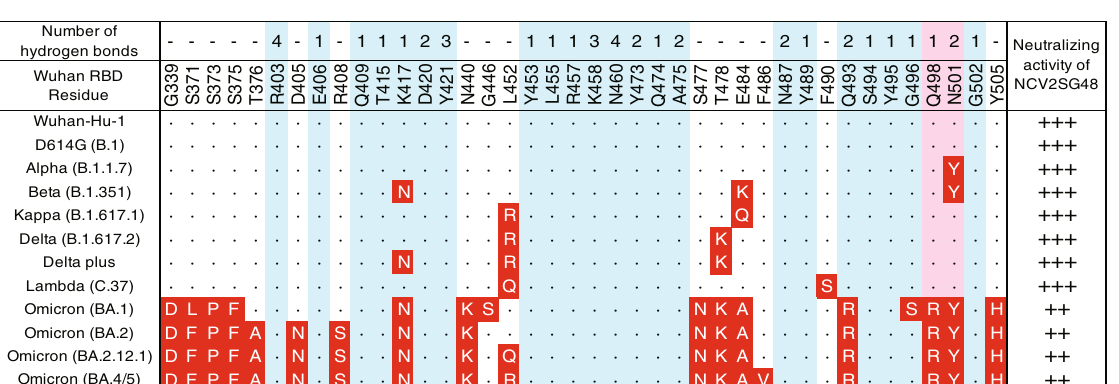
Fig. 5 Conserved binding of NCV2SG48 on Omicron RBD. a Fab of NCV2SG48 complexed with Wuhan RBD ( light red ) or Omicron RBD ( light blue ) is shown on the surface model of Wuhan-Hu-1 RBD. The binding angles of Fab to Wuhan RBD ( red line ) and Omicron RBD ( blue line ). The conformational con fl ict between NCV2SG48 and Omicron RBD is boxed and indicated by the arrow. Residues of a possible crush between NCV2SG48 and Omicron RBD are indicated by a purple dotted line. Wuhan-Hu-1 RBD ( orange ); Omicron RBD ( green ); S32 of NCV2SG48 LC, N501 and Q498 of Wuhan RBD, and Y501 and R498 of Omicron RBD are indicated. b The binding interface area of NCV2SG48 Fab, HC, and LC with Wuhan, Delta, and Omicron BA.1 RBDs. c Binding site of NCV2SG48 on the surface model of Wuhan RBD, Delta, and Omicron RBD. The binding interface of HC ( blue ), LC ( green ), or HC/LC overlapped ( yellow ) is shown. The ACE2-binding site is surrounded by a dotted line ( cyan ). Mutated amino acids are shown in red and residues causing conformational con fl ict with NCV2SG48 are boxed. d The matrix represents amino acid substitutions present in RBD of indicated SARS-CoV-2 variants. The substituted amino acids are shown in red boxes. The numbers of hydrogen bonds of NCV2SG48 to Wuhan RBD are indicated on the corresponding amino acid residue. Residues of blue interact with SARS-CoV-2 RBD. Residues of conformational con fl ict to Omicron RBD are highlighted in pink. IC 50 of neutralizing activity of NCV2SG48 to SARS-CoV-2 pseudoviruses is indicated (IC 50 : +++ , 10 – 99 ng/ml; ++ , 100 – 999